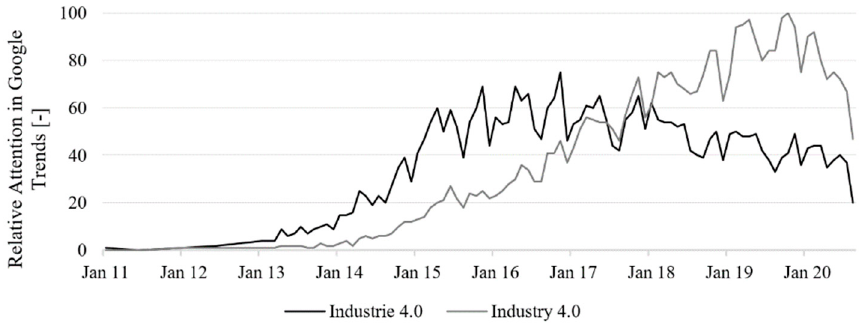
Figure 1. Relative search attention of ‘Industrie 4.0’ and ‘Industry 4.0’ in Google Trends (January 2011 to July 2020).